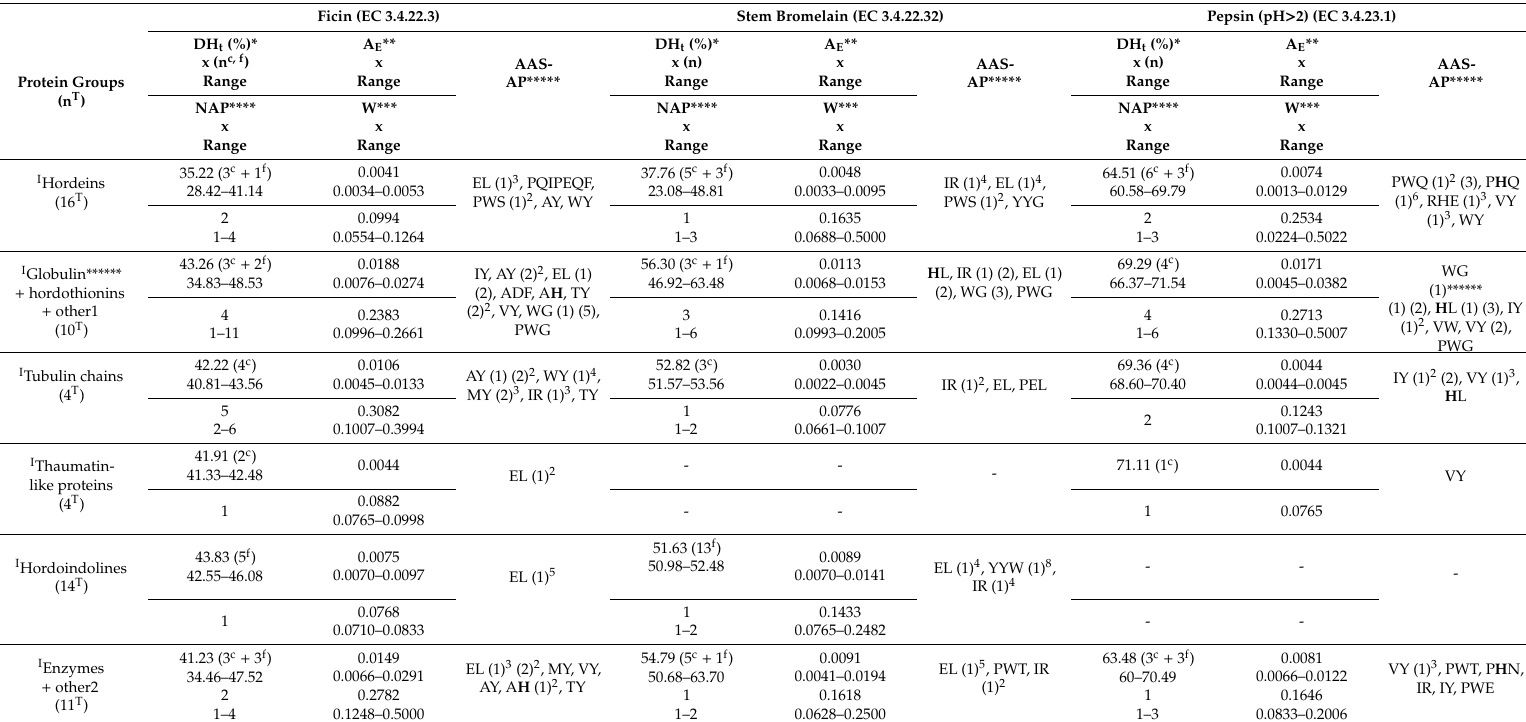
Table 8. The bioparameters characterising the in silico hydrolysis of barley proteins ( I Hordeum vulgare) and the molecular characterisation of the obtained antioxidant